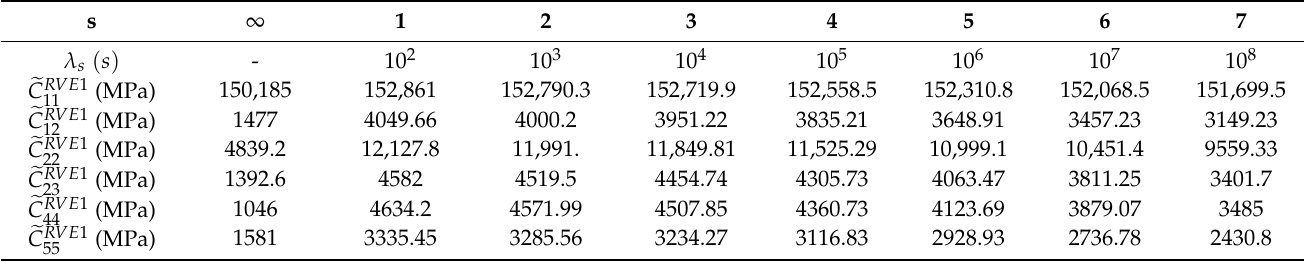
Table A1. The effective viscoelasticity of S-RVE1 at